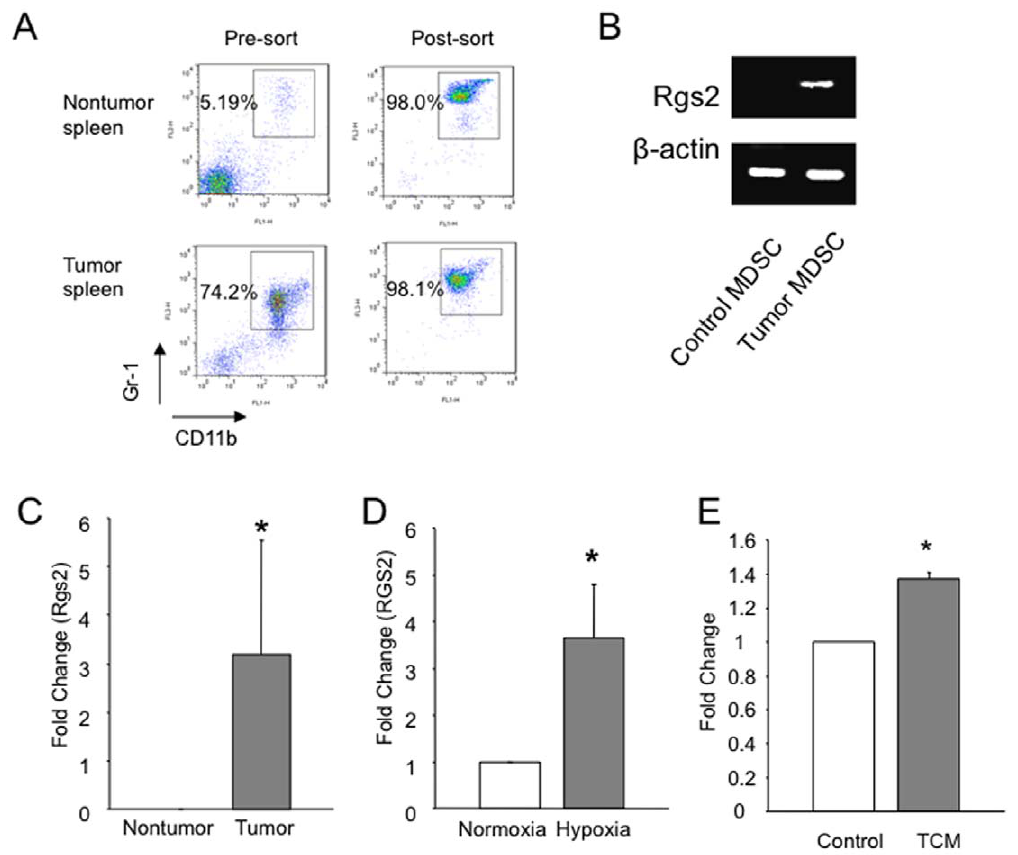
Figure 1. Induction of Rgs2 in tumor derived MDSCs. (A) Purity of cells from isolation of Gr-1 + CD11b + cells using MACS. Spleens from non- tumor bearing and MC26 tumor bearing BALB/c mice were isolated and processed into to single cell suspension, followed by sorting using MACS, as described in the Methods section. (B) and (C) Gr-1 + CD11b + cells were isolated from non tumor bearing and tumor bearing mice, MC26 tumors in BALB/c (B) and 3LL tumors in C57BL/6 (C), by magnetic sorting of pooled splenocytes from 5–10 mice, generating MDSCs of greater than 98% purity. Cells were then subjected to RNA isolation and RT-PCR (B) and real time PCR (C) for Rgs2 expression. These experiments were repeated 3 times. (D) HL-60 cells were incubated under normoxic (20% O 2 ) or hypoxic (1.0–2% O 2 ) conditions for an hour, and RNA was isolated, followed by real time PCR analysis. This experiment was performed 5 times. (E) HL-60 cells were treated with medium conditioned by 3LL tumor cells for one hour. RNA was isolated, followed by real time PCR analysis. The experiment was performed 3 times. * p ,